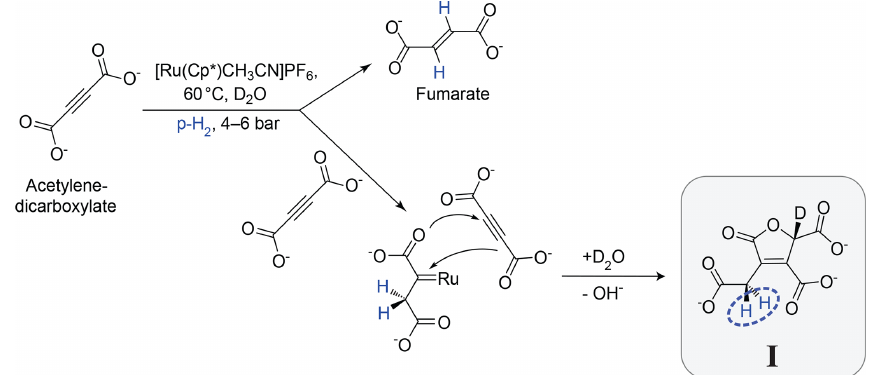
Figure 1. Postulated mechanism for the formation of I . The main hydrogenation reaction leads to the product fumarate. A side reaction, involving a second acetylenedicarboxylate molecule, leads to the product I . The inequivalent methylene (CH 2 ) protons which derive from para -enriched hydrogen are shown in blue.